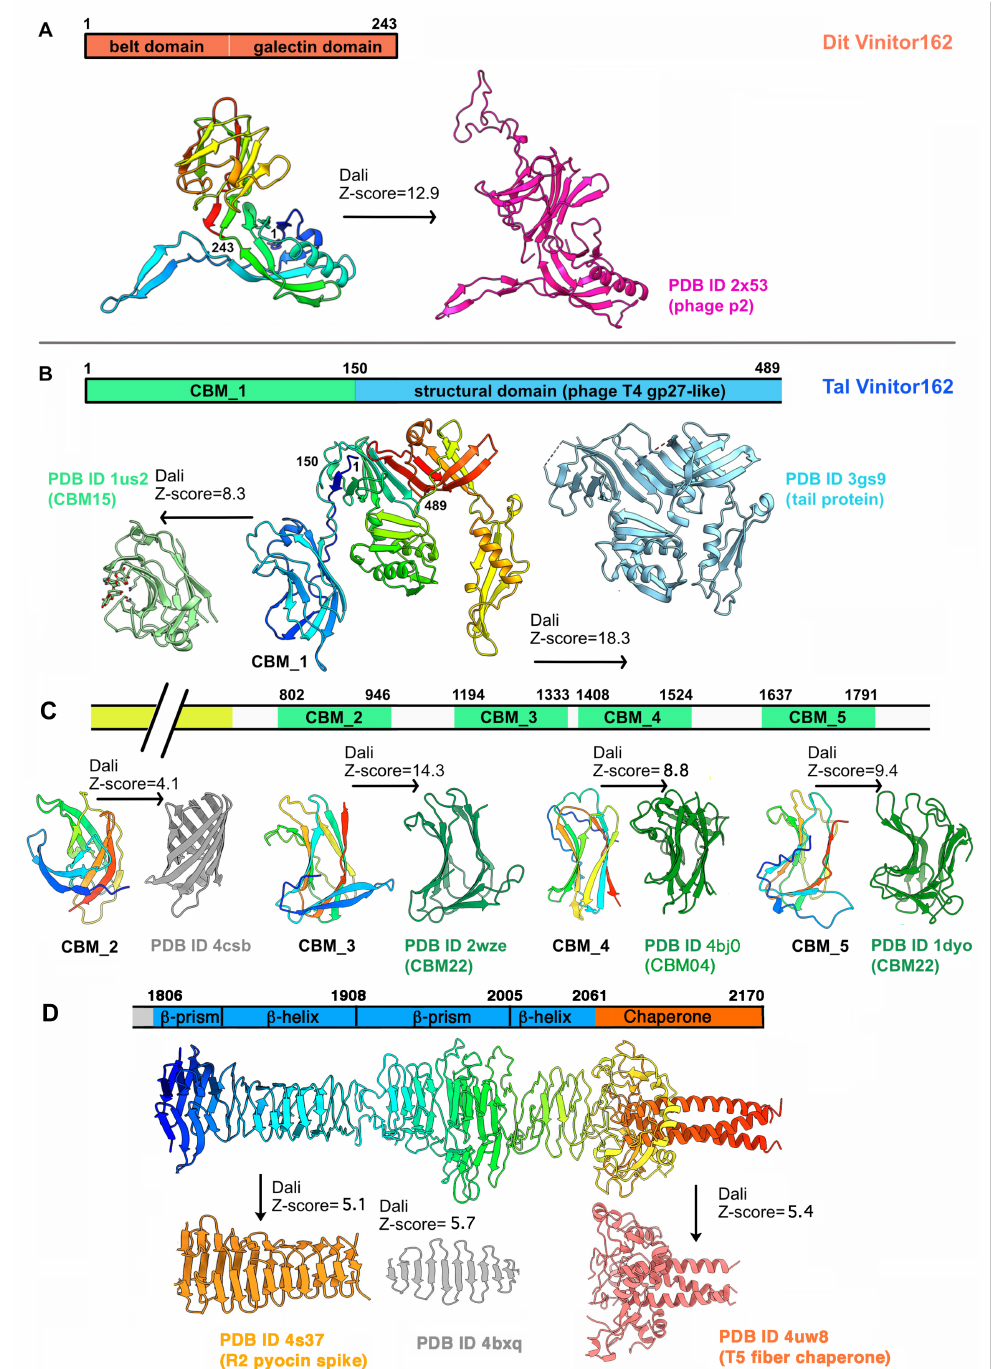
Figure 4. AlphaFold2 structure predictions of Vinitor162 Dit and Tal. ( A ) Dit domain organization (top). Ribbon representations of the predicted belt and galectin domains (rainbow) and the phage p2 Dit belt–arm and galectin domains (pink). ( B ) Tal domain organization in the N-terminal region (top). Ribbon representations of the Tal and CBM_1 predicted structure s(rainbow) and their Dali hits, the listerial phage EGD-e Tal structural domain (light blue), and a CAZy CBM15 (light green), respectively. ( C ) Tal domain organization in the middle of the protein (top). Ribbon representations of the predicted CBM_2 to CBM_5 (rainbow) and their Dali hits. Besides CBM_2, the three other CBMs correspond to CAZy CBM22, CBM4, and CBM22. ( D ) Tal domain organization in the C-terminal region (top). Ribbon representations of the predicted Tal C-terminal domain (rainbow) compared to Dali hits, a R2 pyocin spike (orange), and a T5 fiber chaperone (pink) at each